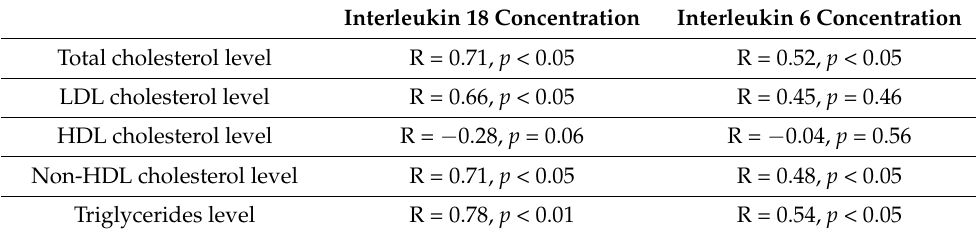
Table 2. Correlation between cholesterols fraction levels and interleukins